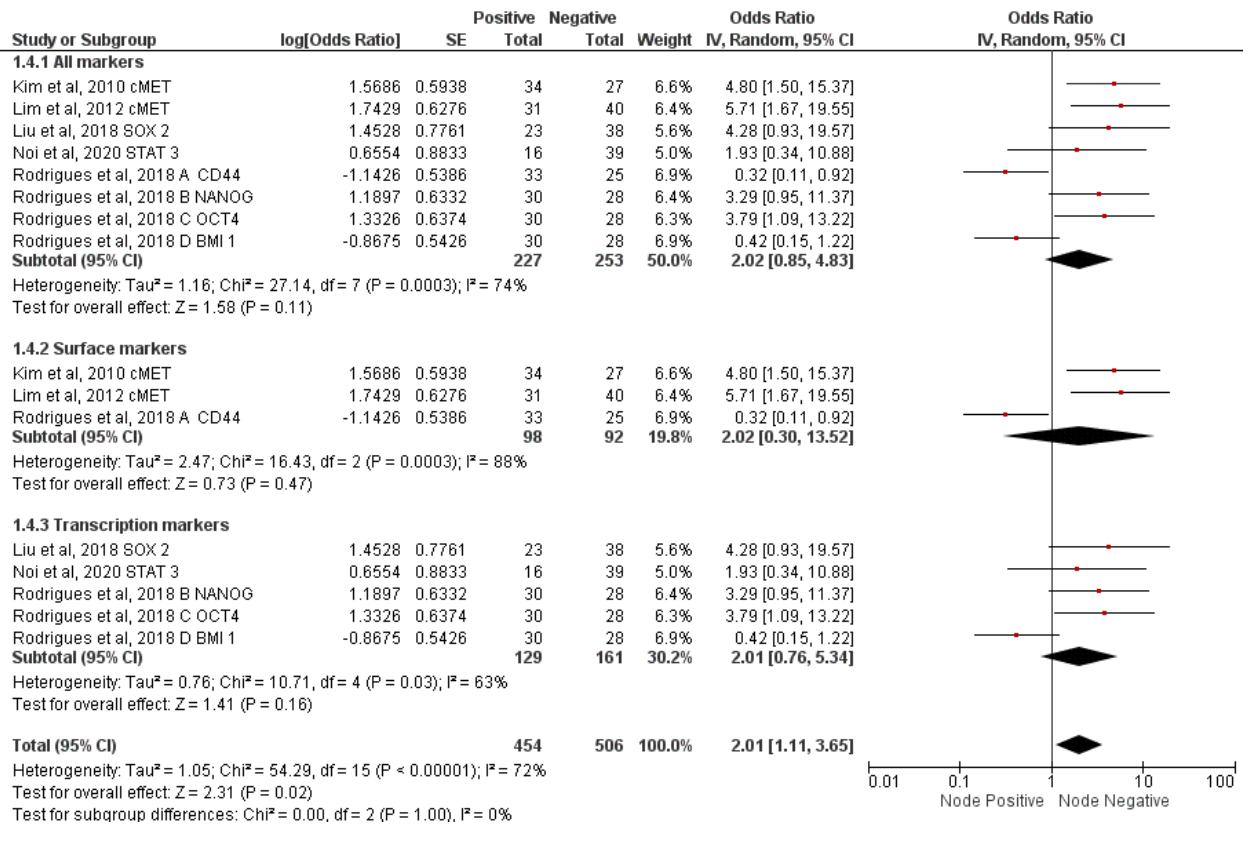
Figure 4. Meta−analysis of CSC markers and nodal metastasis [29,30,32–34]. Figure 4. Meta − analysis of CSC markers and nodal metastasis [29,30,32–34].